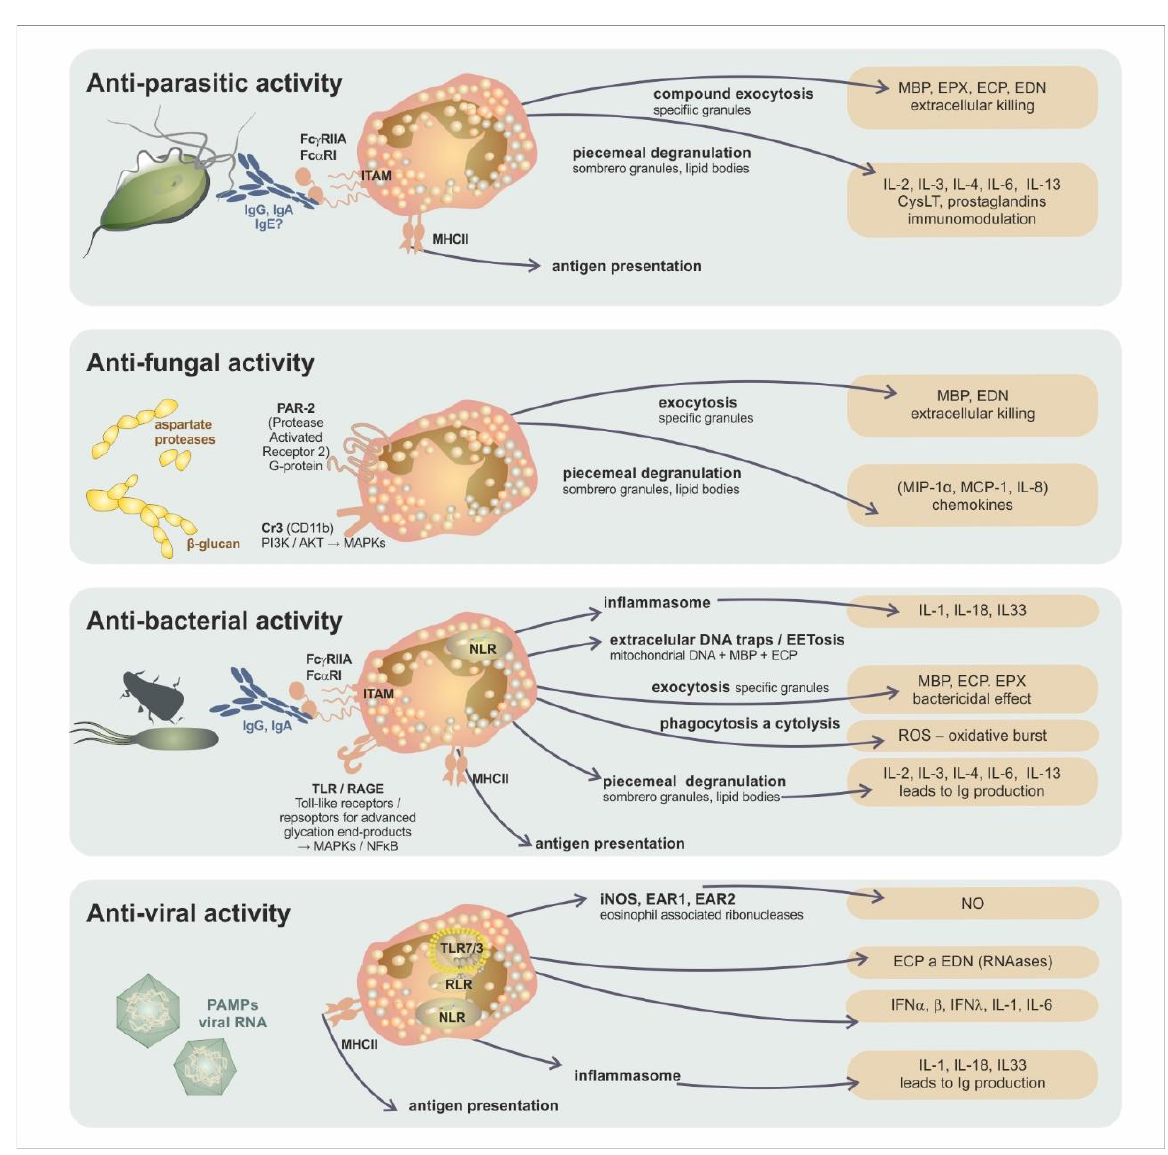
Figure 4. Antimicrobial functions of eosinophils. Eosinophils are multipotent defence cells that provide protective immunity against parasitic, fungal, bacterial, and viral infections. They can interact with microbial bodies, inactivating or killing them in several ways. These features are dependent upon the unique mechanism of protein secretion employed. For a more detailed explanation of the mentioned mechanisms, see Table 3. Table 3. Antimicrobial roles of eosinophils.